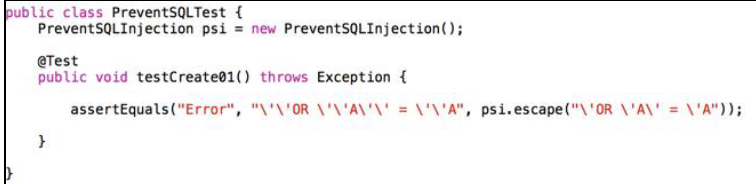
Figure 18. Part of the test case for Student 1 using the existing method.